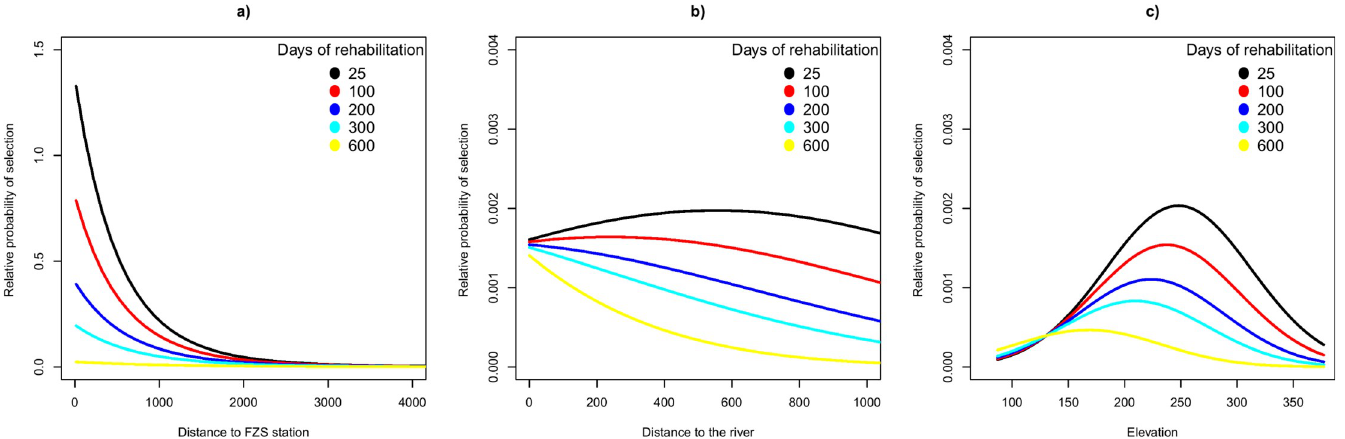
Fig 3. Time spent in rehabilitation affects resource selection patterns. Relative probability of selection in 32 orangutans (n = 13 females, n = 19 males) as a function of the number of days spent in rehabilitation prior to their release (five different scenarios) interacted with the distance to the FZS station (a, in meters), the distance to the nearest river (b, in meters), and elevation (c, in meters). The lines represent the average relative probability of selection as predicted by the resource selection function.